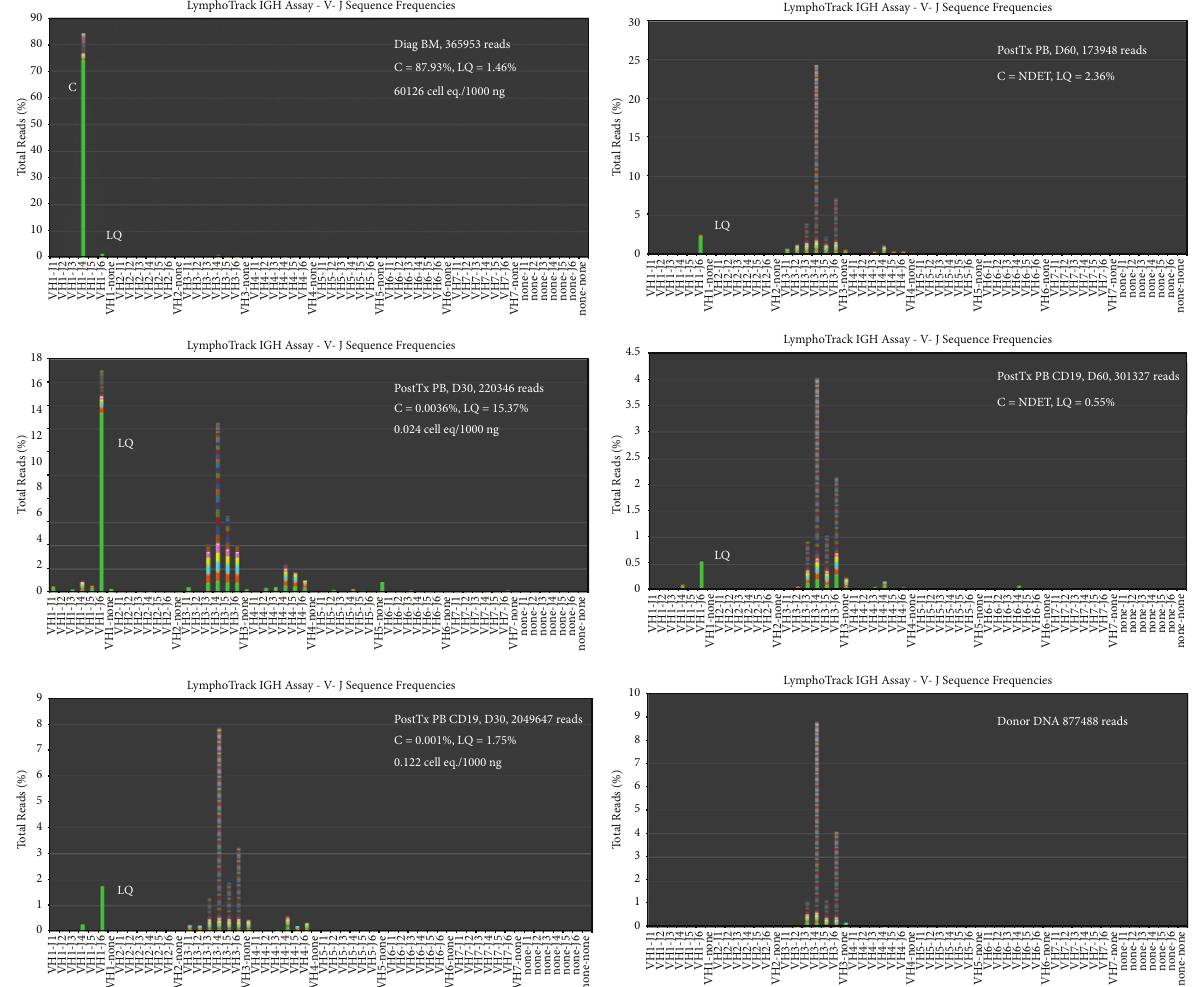
Figure 5: MRD after allogeneic transplant. Clonal reads were still present at day 30 after allotransplant in total DNA and CD19+ DNA but were extremely few in number to be visualized on the Y -axis. Clonal reads were not detected in total DNA and CD19+ B-cell DNA in peripheral blood (PB) at day 60 after transplant. The B-cell repertoire in the peripheral blood shows successful expansion and diversity at days 30 and 60 after transplant. C: clonal and LQ: clonally related DLBCL have a much poorer prognosis than patients who develop clonally unrelated DLBCL [12, 13].